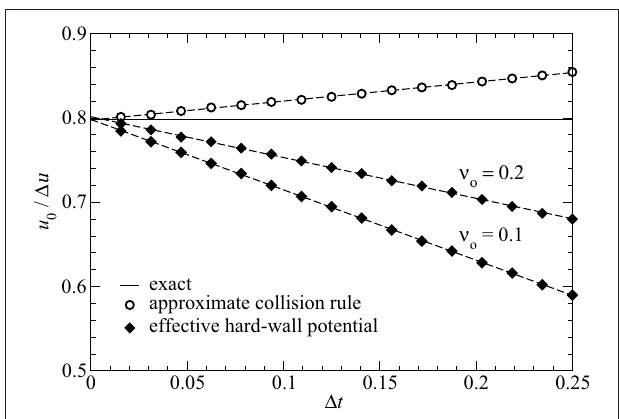
FIGURE 1 | Mean displacement u 0 as a function of time step 1 t when using (a) approximate collision rules (open circles) and (b) harmonic effective hard-wall potentials (closed diamonds) for two different values of ν o , see Equation (14). Dashed lines show linear fits, the solid line the exact, analytical solution. The equilibrium site of the spring is placed at u s k B T 1 u 2 = =